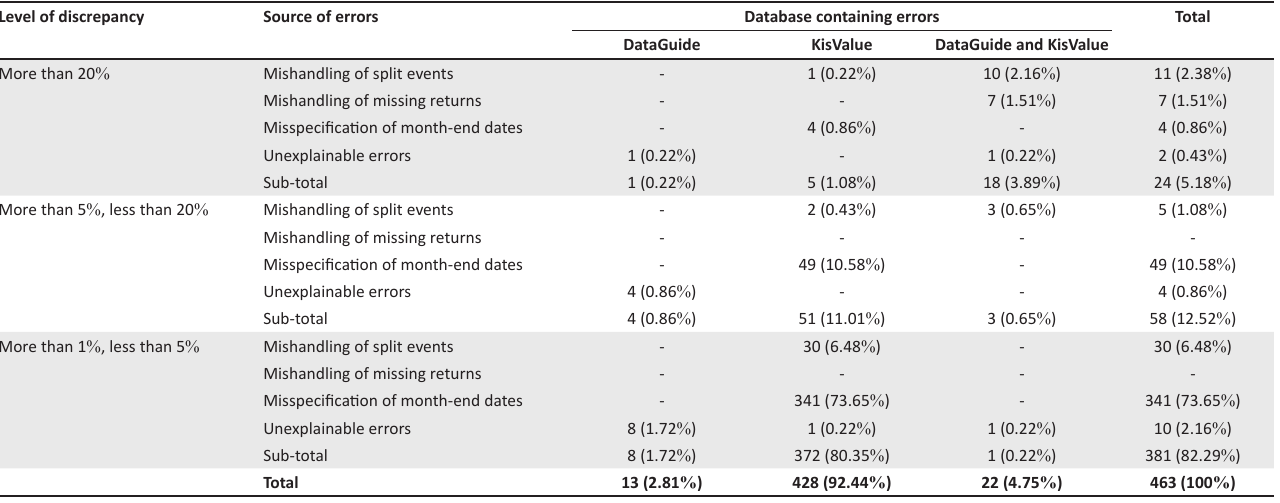
TABLE 3: The distribution of data errors resulting in discrepancies greater than 1 % between monthly stock returns data in the DataGuide and KisValue by databases containing errors. Level of discrepancy